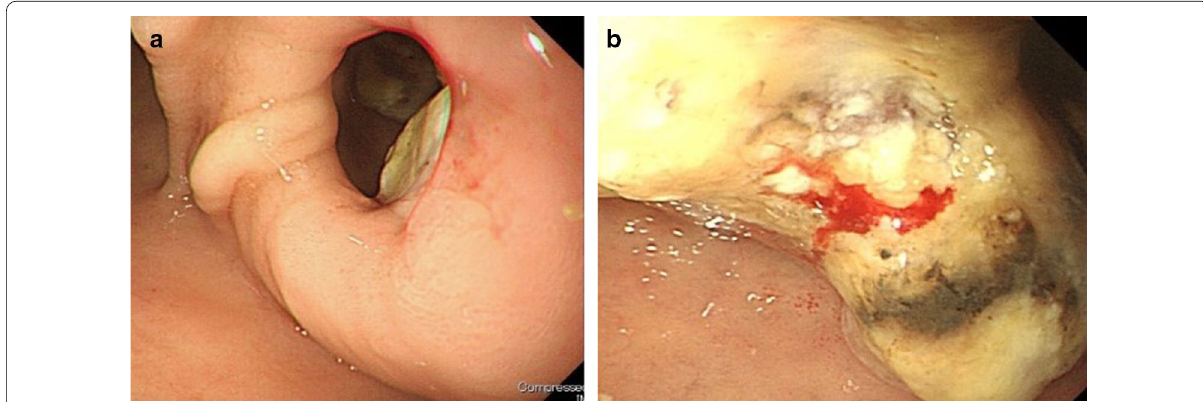
Fig. 1 Upper gastrointestinal endoscopy. a Pylorus observed from the stomach side. b Duodenal bulb lumen. An irregular tumor occupying the lumen of the duodenal bulb was revealed. The biopsy result was adenocarcinoma